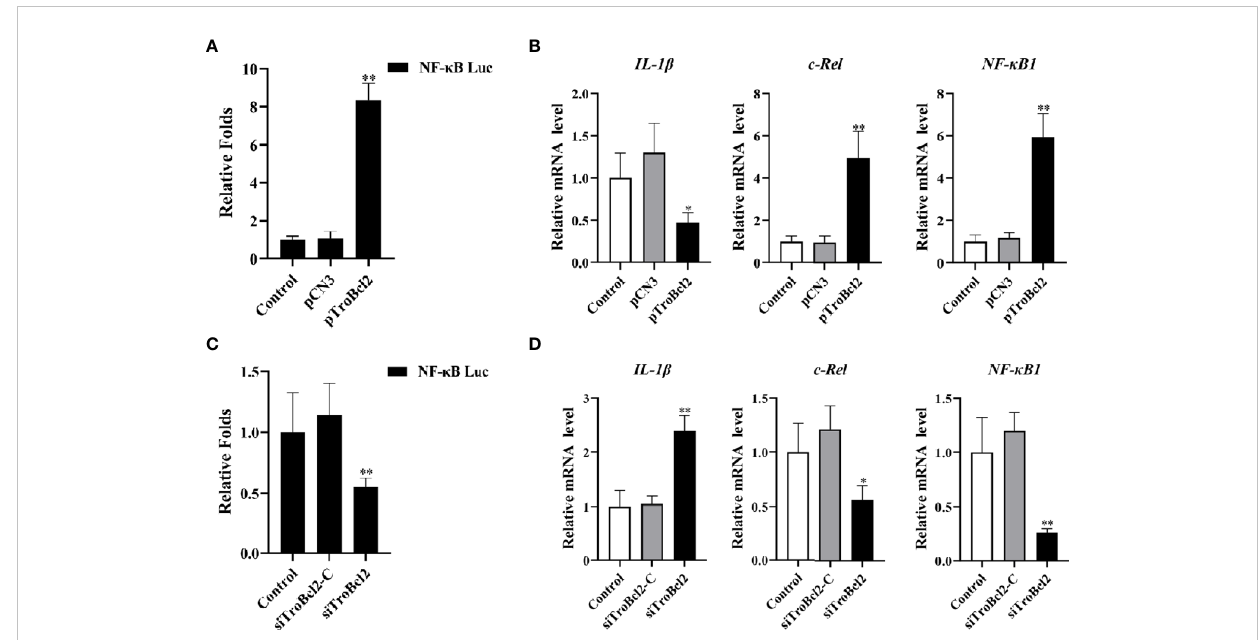
FIGURE 9 Effect of TroBcl2 overexpression and knockdown on the expression of NF- k B signaling pathway-related genes and NF- k B promoter activation following LPS stimulation. (A) GPS cells were co-transfected with NF- k B-pGL 4.32, pRL-CMV, pTroBcl2 (or pCN3), then treated with LPS. Non- transfected cells treated with LPS were as the control. The luciferase activity of the NF- k B promoter in the cells was detected. (C) GPS cells were co-transfected with NF- k B-pGL 4.32, pRL-CMV, siTroBcl2 (or siTroBcl2-C), then treated with LPS. Non-transfected cells treated with LPS were as the control. The luciferase activity of the NF- k B promoter in the cells was detected. qRT-PCR analysis of the expression levels of NF- k B1 , c-Rel , and IL-1 b in GPS cells transfected with pTroBcl2 and pCN3 (B) or siTroBcl2 and siTroBcl2-C (D) upon LPS treatment. Non-transfected cells treated with LPS were as the control. Error bars display means ± SD (N = 3). N, experimental number. ** P <